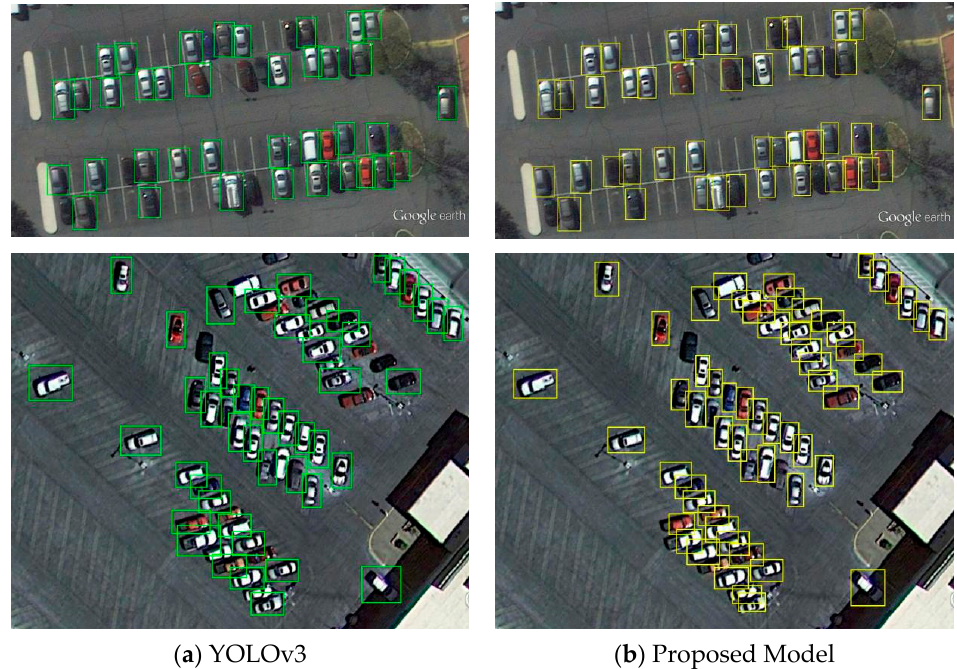
Figure 4. Detection results of YOLOv3 and our model in densely arranged objects detection. The pictures in the first column are the result of YOLOv3, which shows the detection result in green boxes; while the pictures in the second column are the results of our model, which uses yellow boxes to display the detection results. In the first row of pictures, the cars are arranged vertically, and the adjacent bounding boxes overlap a small area; in the second row of pictures, there are many cars with oblique orientation, and the adjacent bounding boxes overlap a large area.